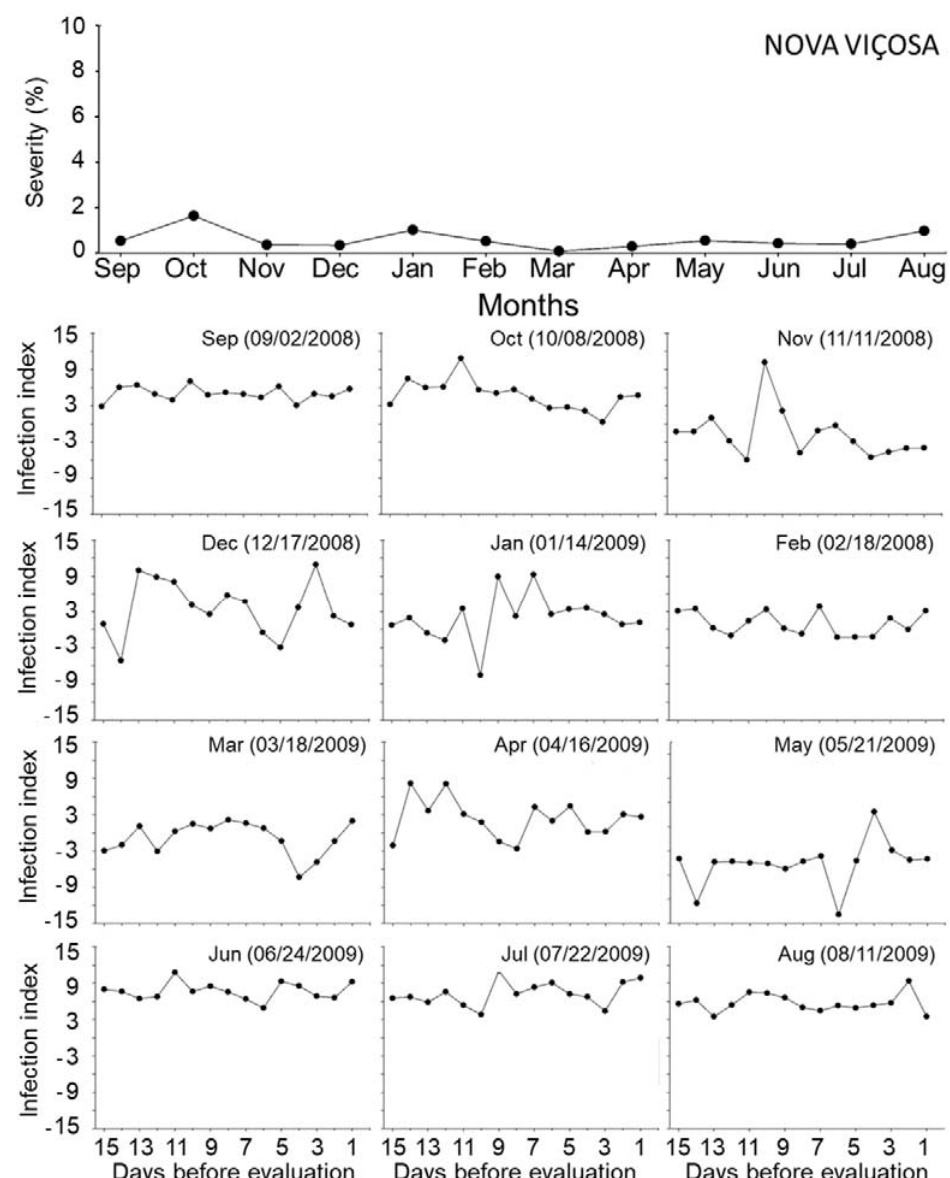
Figure 9. The severity (%) and infection index of eucalyptus rust were evaluated under field conditions and used to calculate the infection index according to the equation of [11], for the 15-day period prior to our monthly evaluations conducted from September 2008 through August 2009, in the municipality of Nova Viçosa, located in the extreme south of Bahia, Brazil.